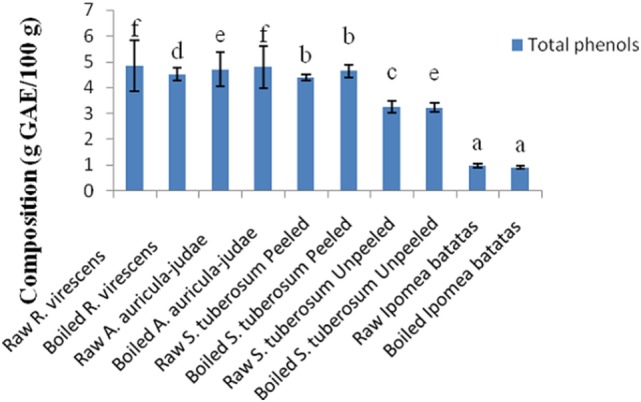
Total phenol contents of aqueous extracts of raw and boiled mushrooms, potato, and sweet potato. Values are reported as means ± SD. (a–f) Means with different superscripts are significantly different (P < 0.05) across the groups. GAE, gallic acid equivalence.